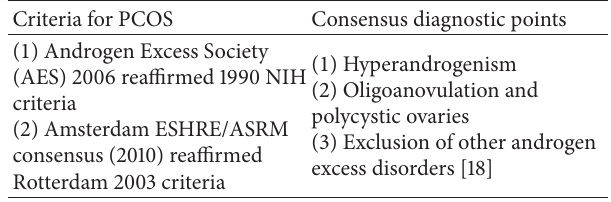
Table 1: Frequency of different clinical features of PCOS. Clinical signs and symptoms of PCOS